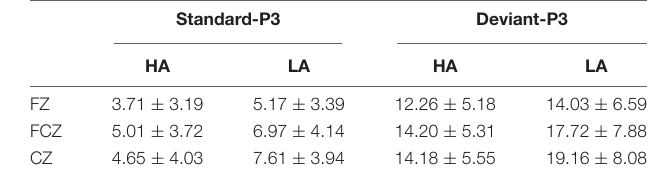
TABLE 3 | P3 mean amplitudes elicited by standard and deviant conditions at Fz, FCz, and Cz sites in LA and HA residents ( M ± SD